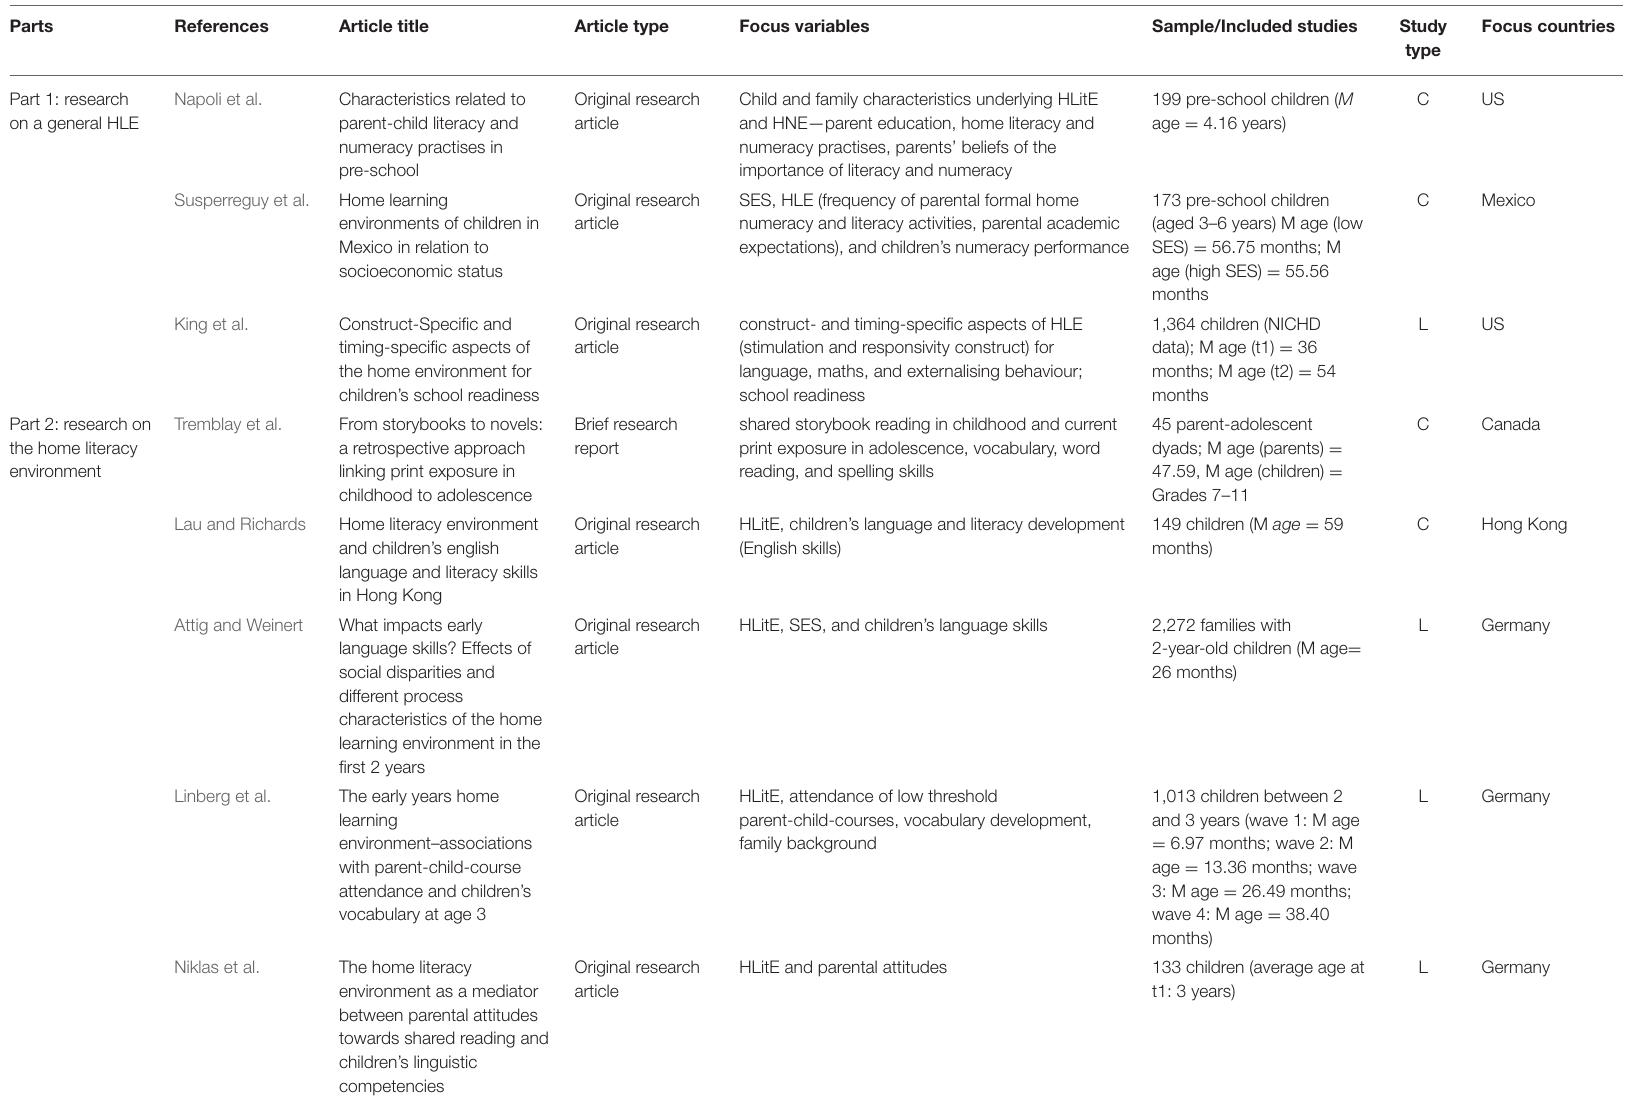
TABLE 1 | Overview of the articles included in the Research Topic on home learning environment and child outcomes.